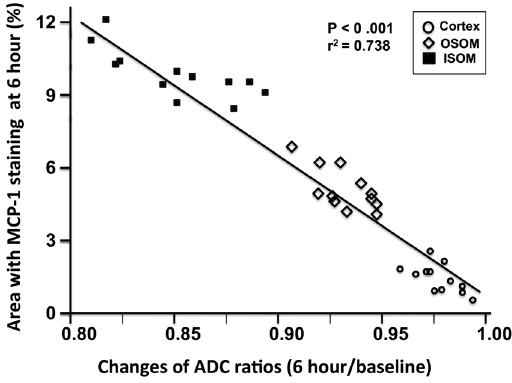
Figure 5. Simple regression analysis of the rats (twelve kidneys) in Group 2 sacrificed at 6 hours after the MRI studies shows a significant inverse correlation between the percentage area with MCP-1 staining and 6-hour/ baseline ADC ratios (P < 0.001, r 2 =